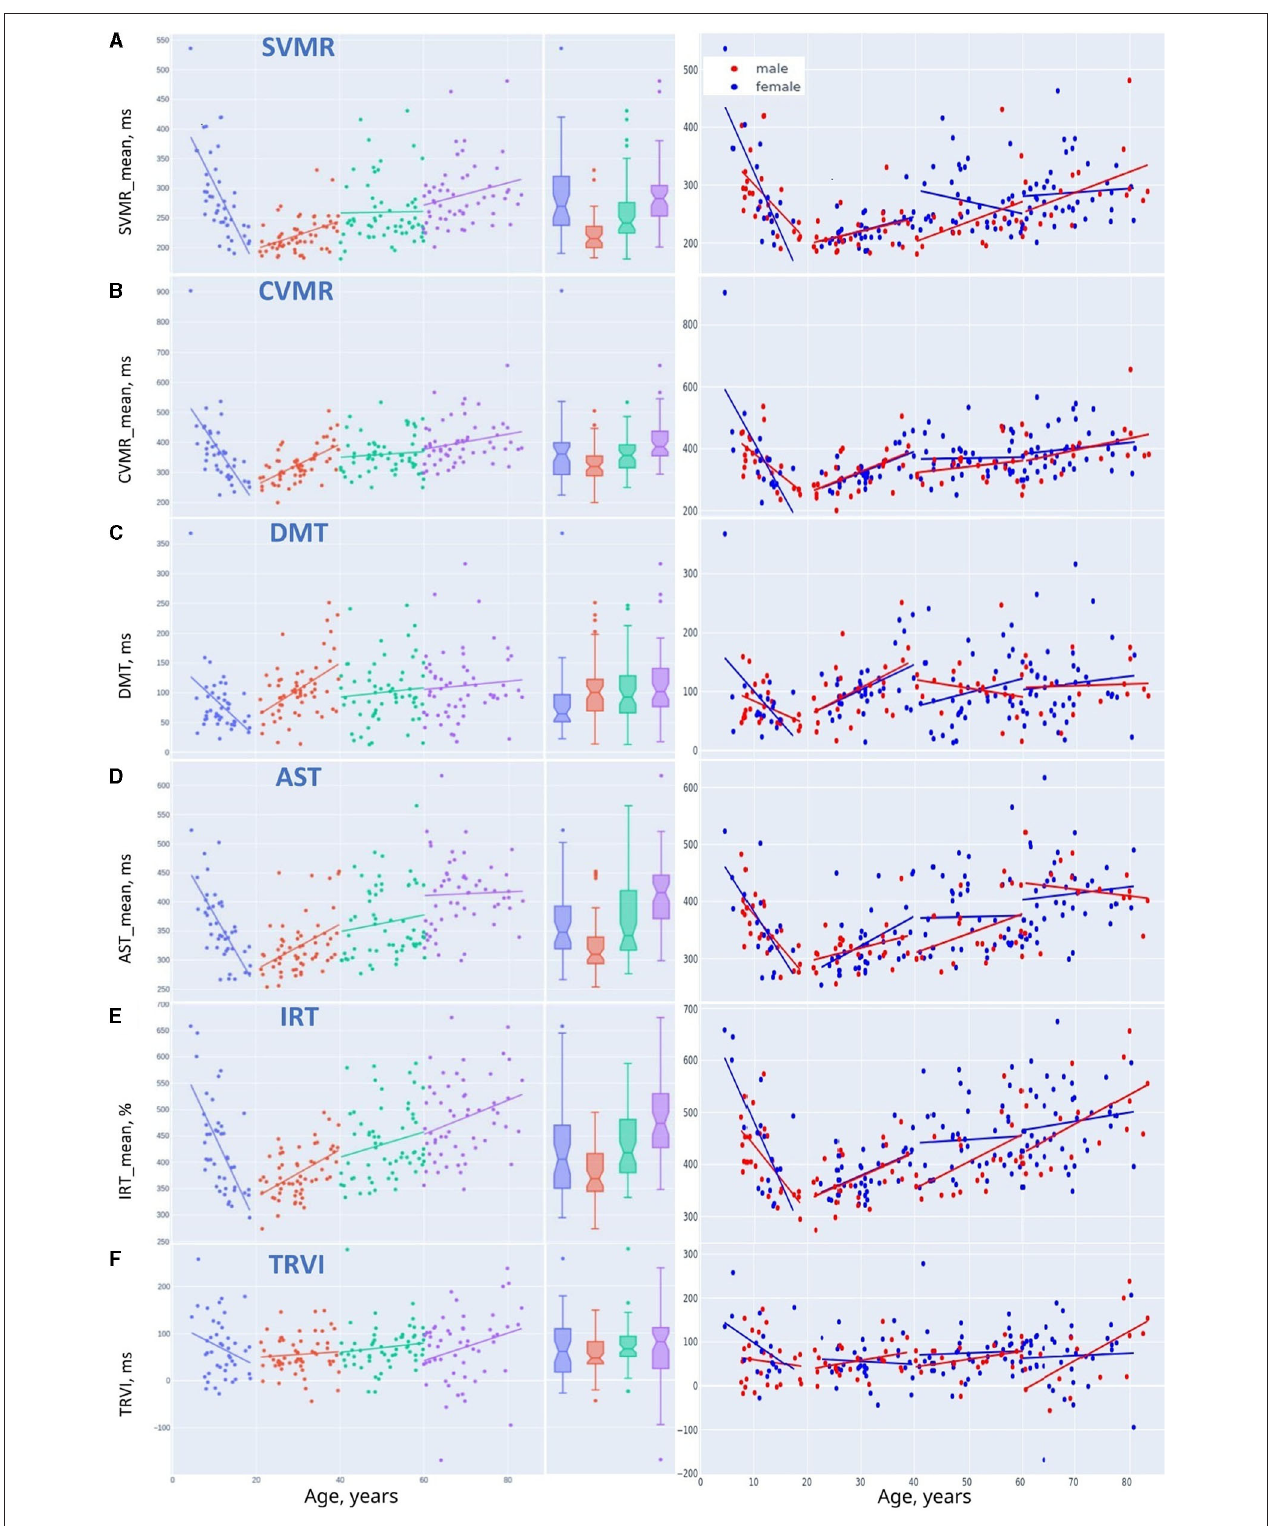
FIGURE 8 | Linear trendlines of performance in psychophysiological tests in age groups: (A) SVMR_mean, (B) CVMR_mean, (C) DMT, (D) AST_mean, (E) IRT_mean, and (F) TRVI.